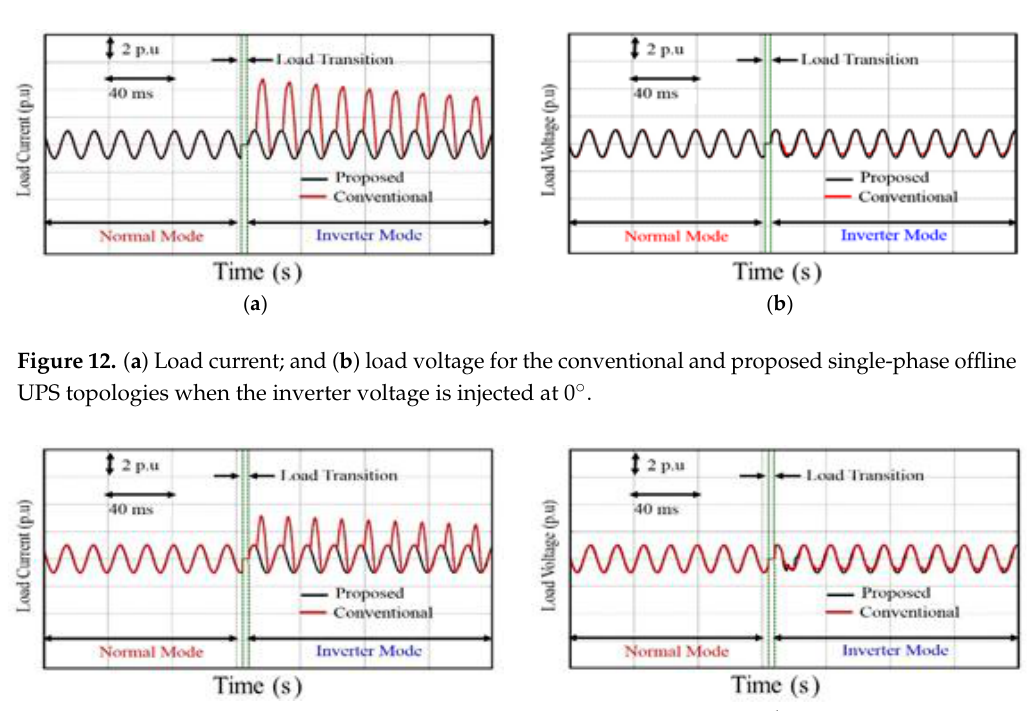
Figure 13. ( a ) Load current; and ( b ) load voltage for the conventional and proposed single-phase offline UPS topologies when the inverter voltage is injected at 30°.